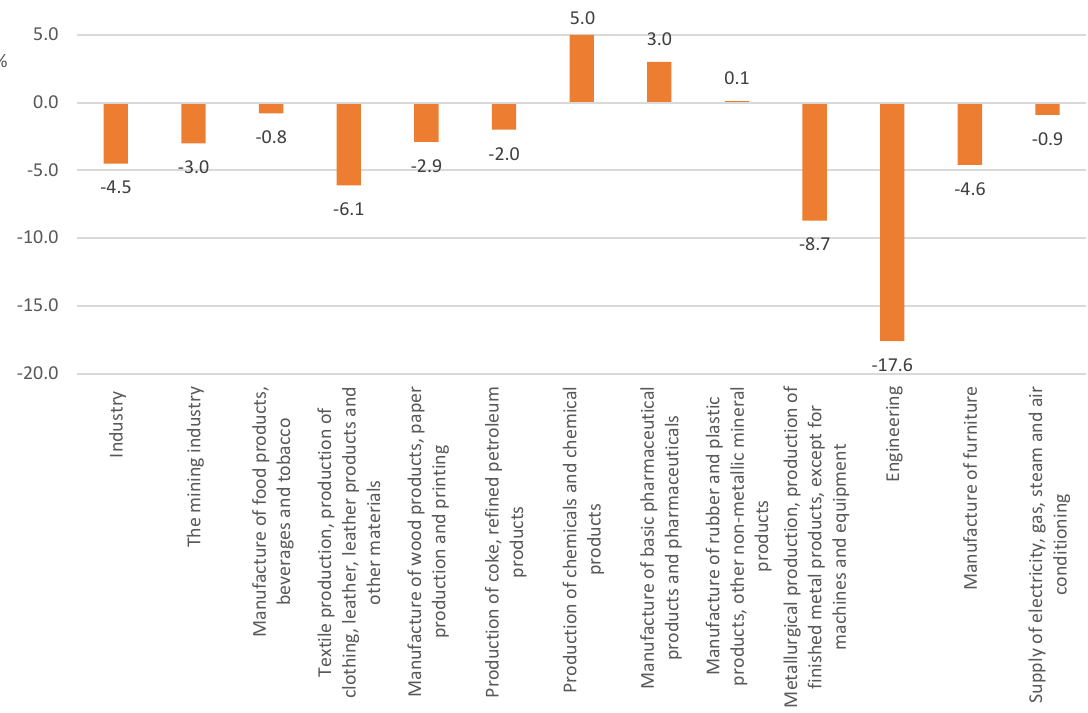
Figure 2. Dynamics of industrial production by economic activity types, 2019–2020 in